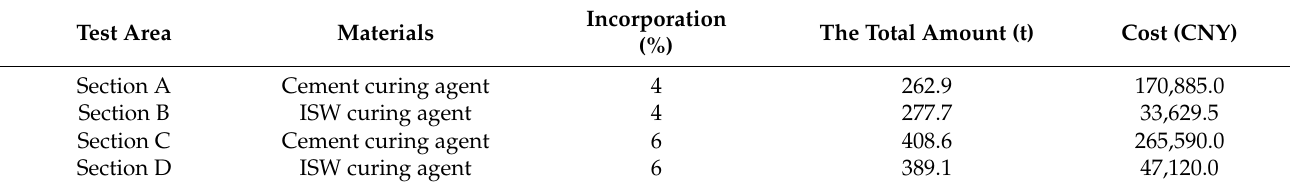
Table 7. Cost comparison of raw materials in the test